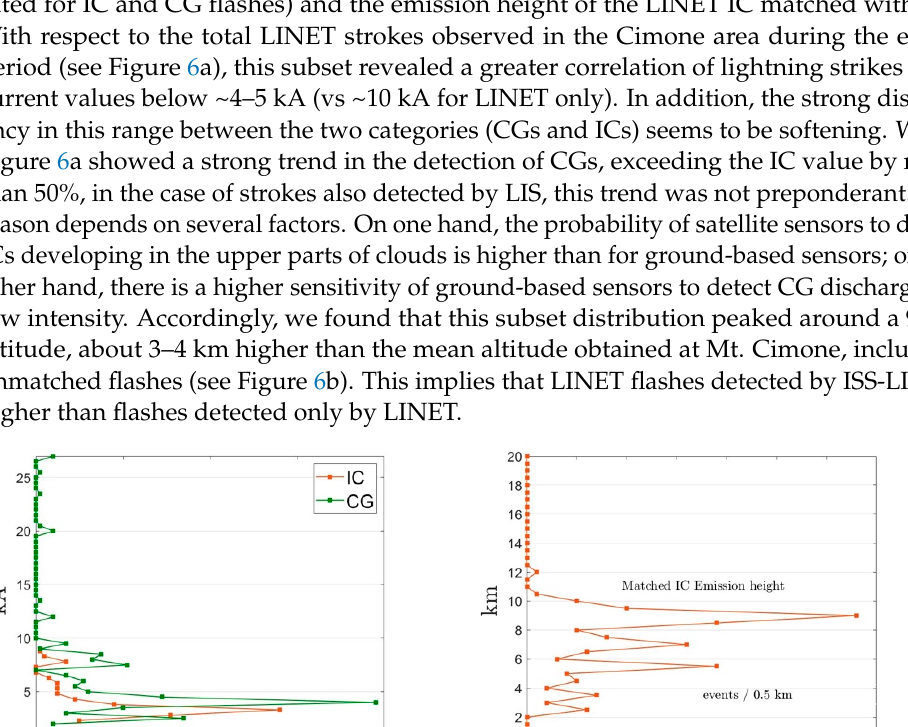
Figure 10. ( a ) LINET IC matched lightning amplitude distribution in the Mt. Cimone area divided into CG and IC data in steps of 0.5 kA. Area considered: 100 km radius around the observatory. Data range: January–December 2020; ( b ) LINET IC matched emission height (steps/0.5 km). Area considered: 100 km radius around the Mt. Cimone Observatory. Data range: January–December